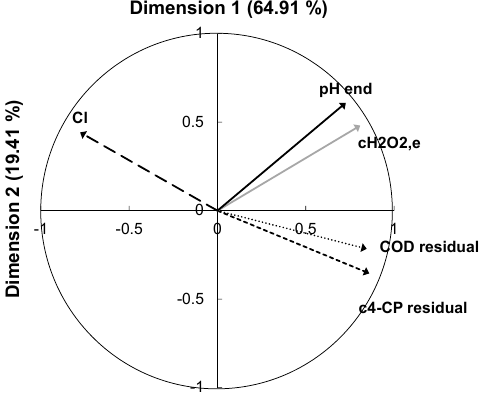
Figure 3. Biplot of the Principal Component Analysis (PCA) performed on the output parameters.